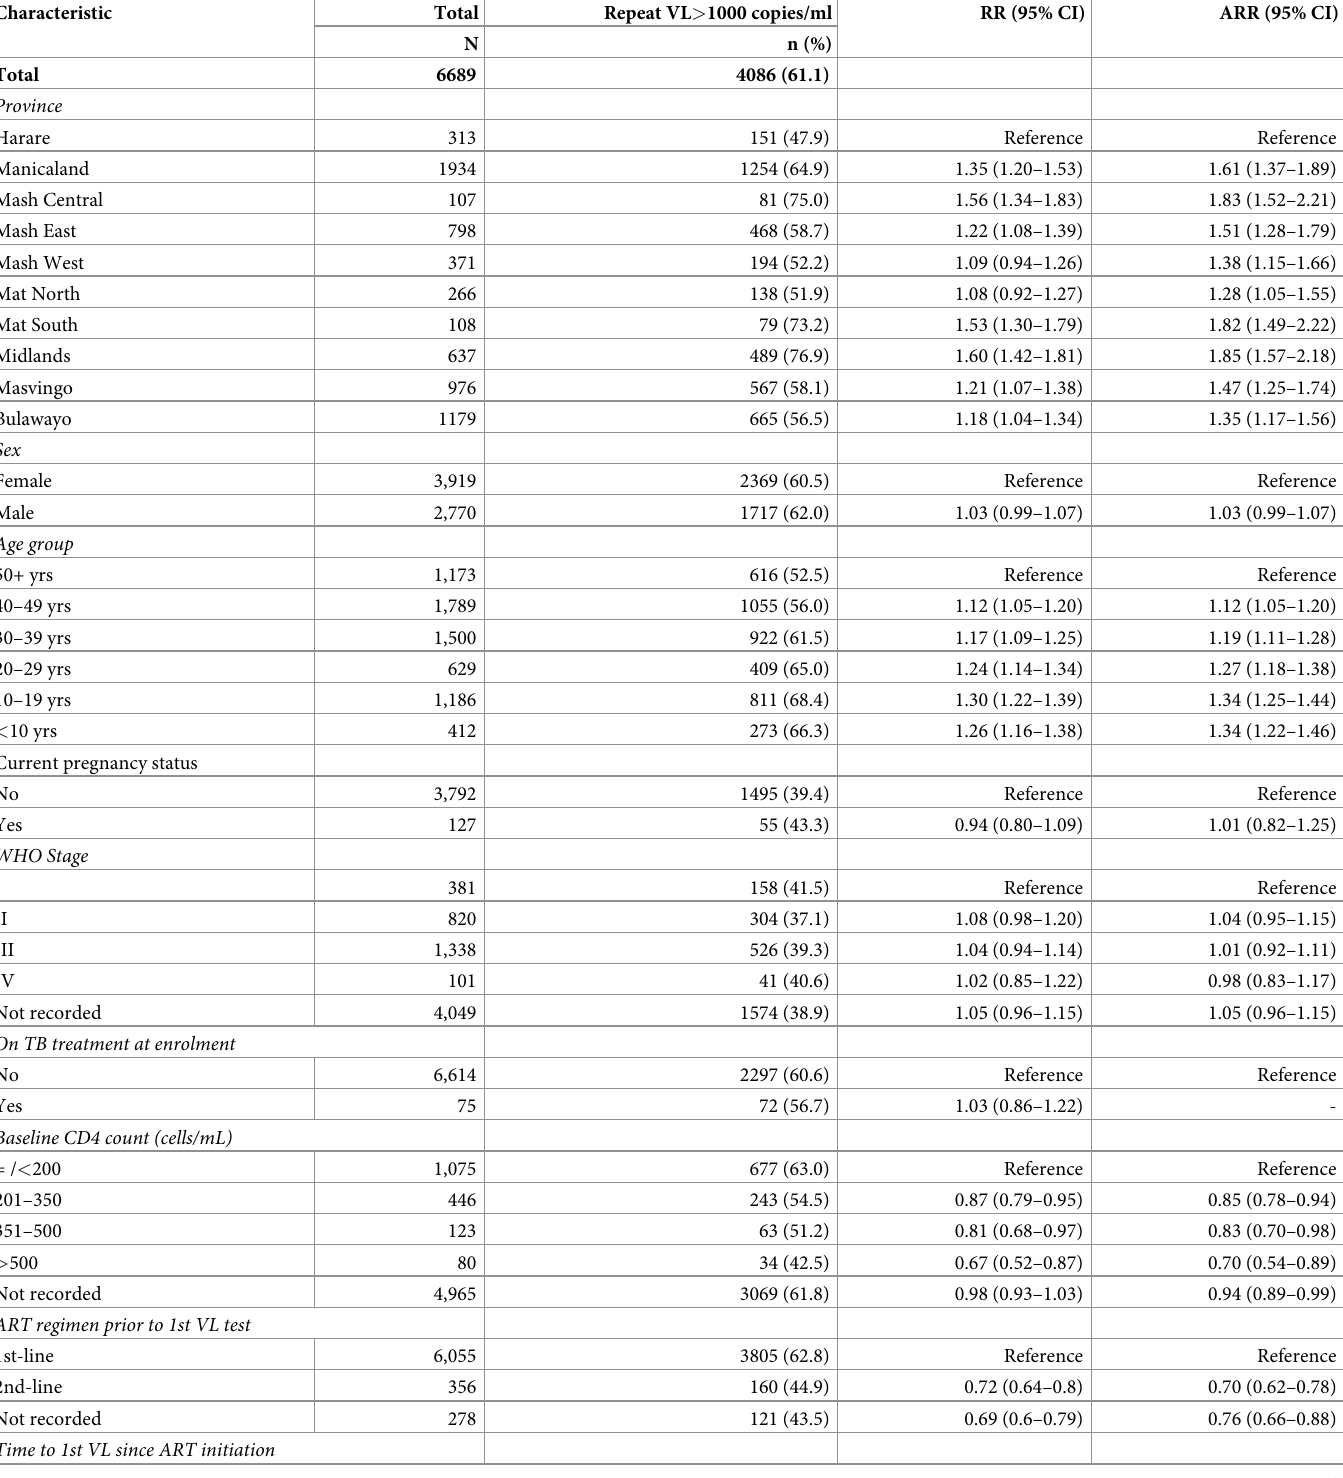
Table 3. Generalized linear regression model of demographic & clinical characteristics associated with confirmed virologic failure on repeat testing among PLHIV in ART care for � 12 months at health facilities using the electronic Patient Management System from 2004 to 2017 in